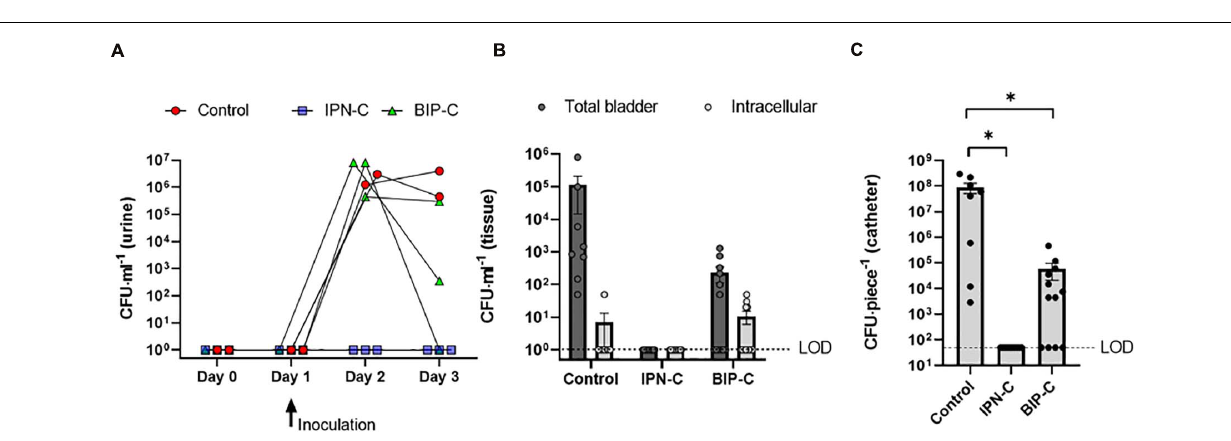
Figure 6B . Tissue-adherent bacteria were present in all